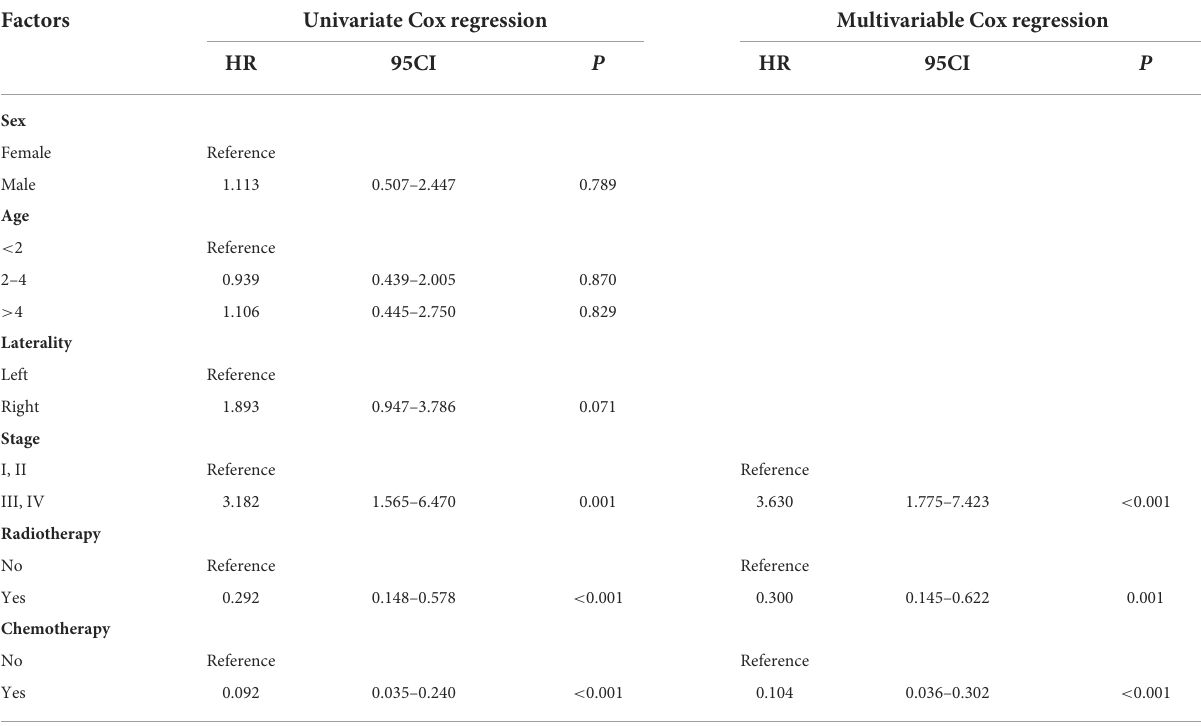
TABLE 3 Univariate and multivariate Cox regression in OS